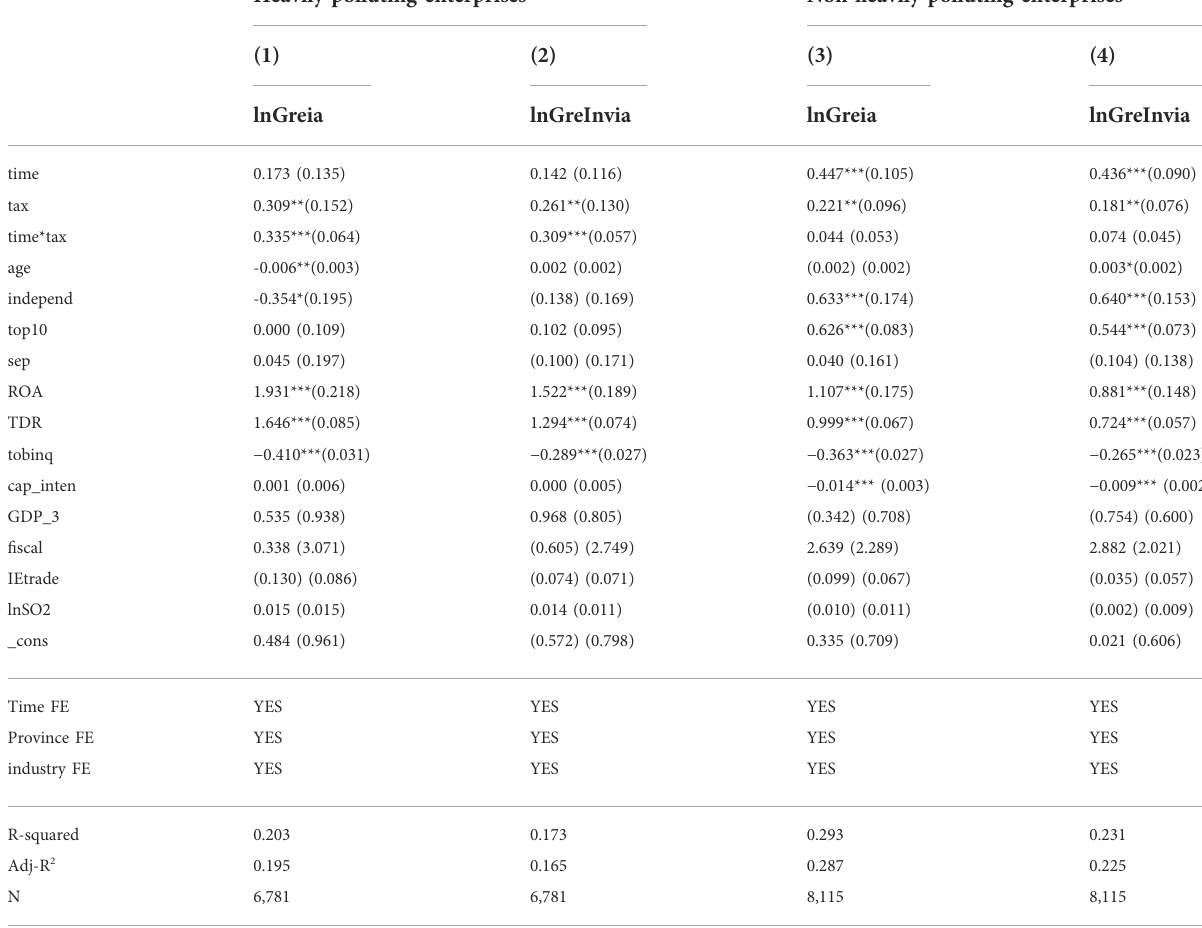
TABLE 8 Regression results by degree of industry